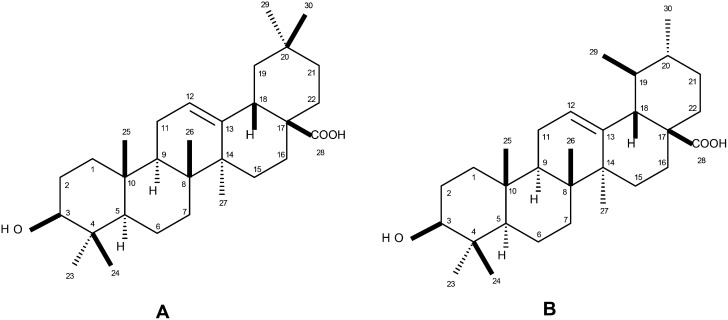
Structures of oleanolic (A) and ursolic acids (B).